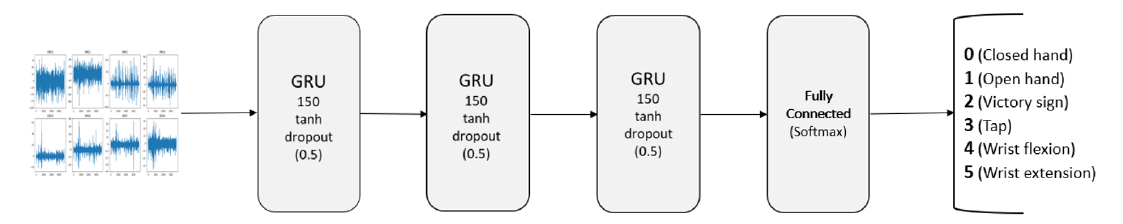
Figure 6. Proposed neural network architecture for hand gesture